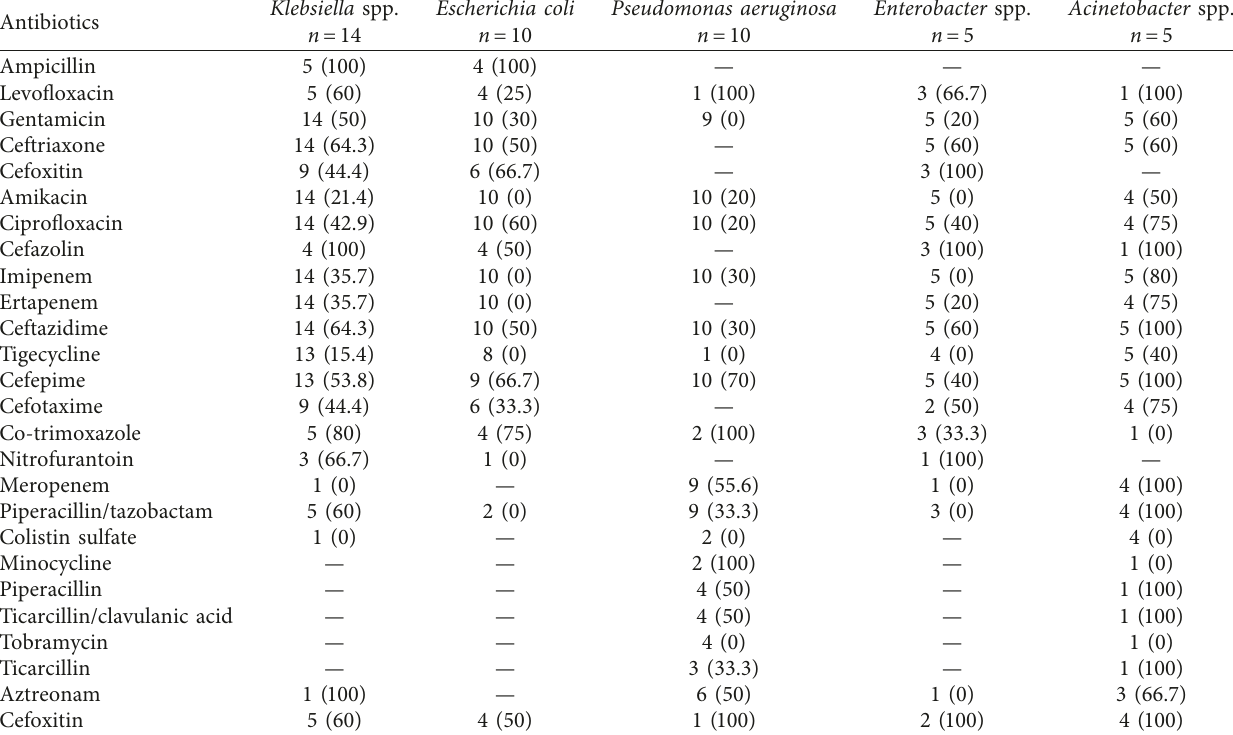
Table 4: Resistance pattern of gram-negative bacteria to antibiotic